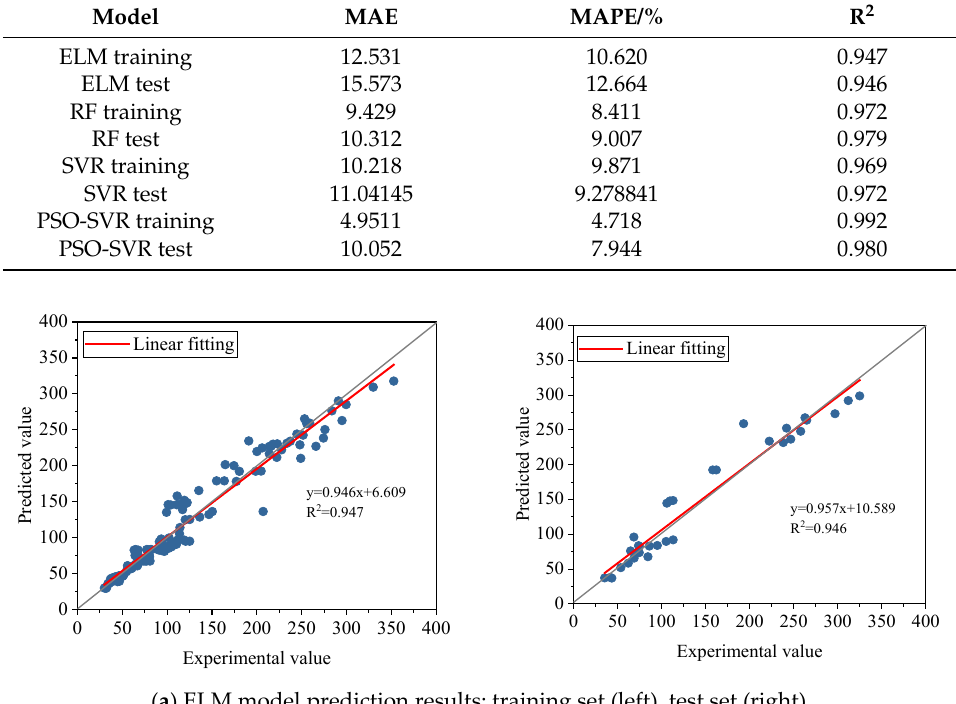
Table 3. Evaluation indicators of four models.